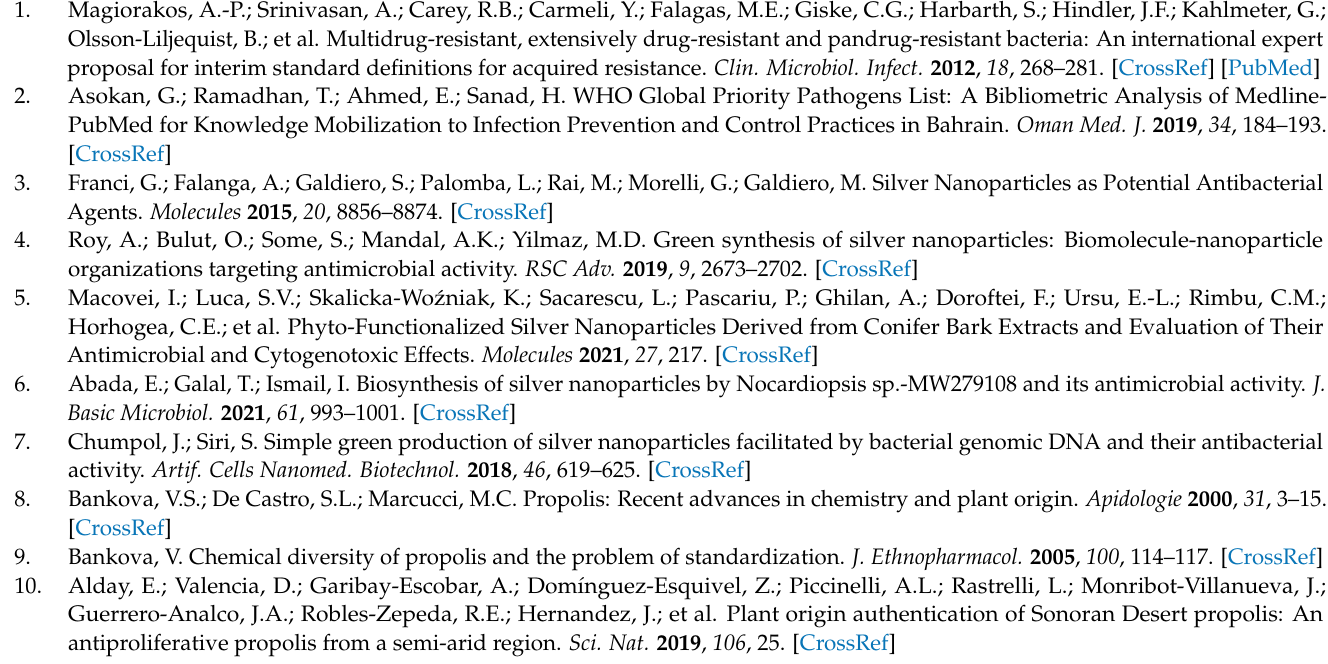
for 144 h, Figure S2: Cytotoxic activity of SPw-AgNPs and SP against ARPE-19 and HeLa cell lines. Data represent the mean of three independent experiments ± standard deviation, Table S1: Phenotypic and genotypic characteristics of analyzed clinical isolates of multidrug resistant E. coli